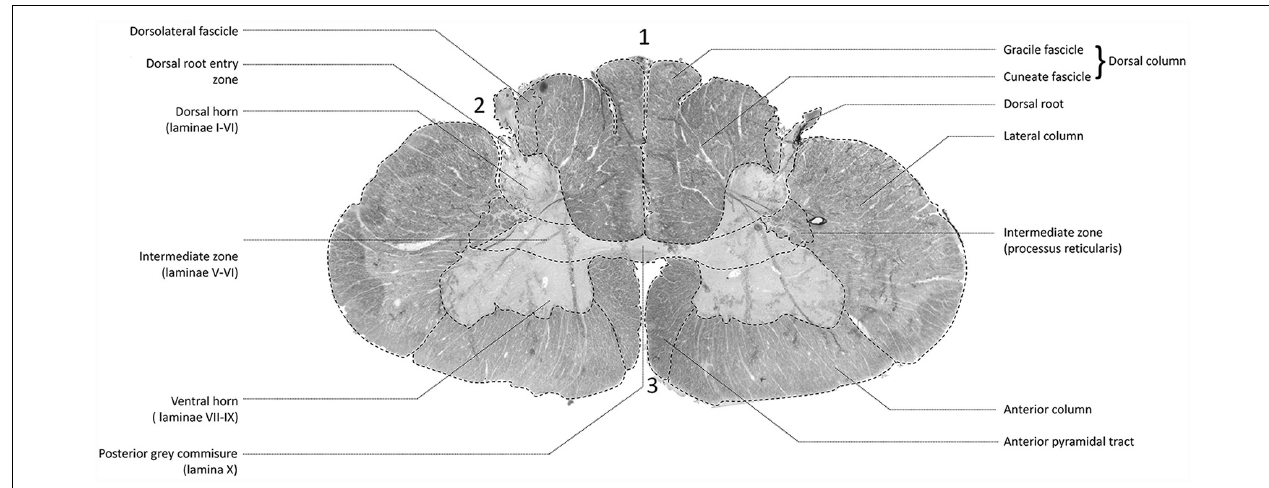
FIGURE 2 | Transmittance image of a transverse section of the cervical spinal cord at level C5–C6 (specimen 2). 1: posterior median sulcus (PMS). 2: dorsolateral sulcus, 3: anterior median fissure.